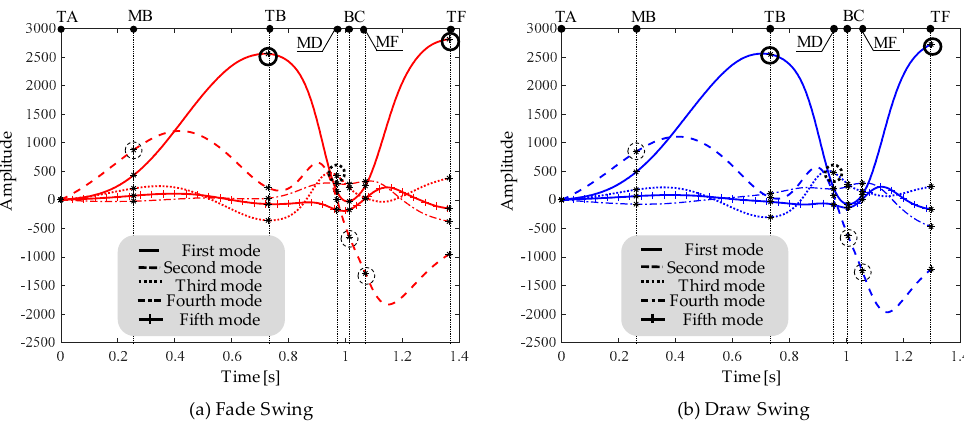
Figure 5. Comparison of temporal behaviors up to fifth mode: ( a ) draw swing, ( b ) fade